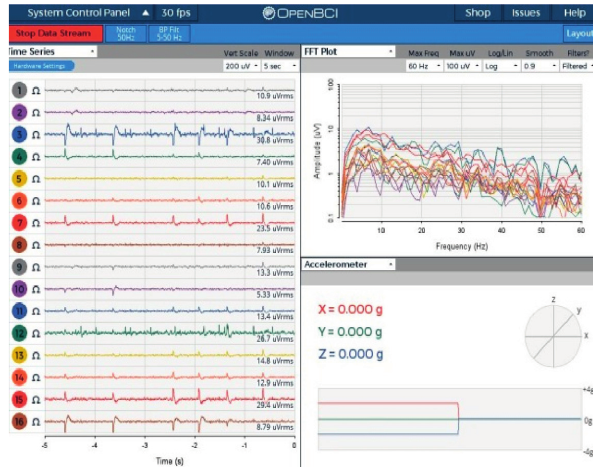
Figure 6: The EEG of grasp action idea in the static state.